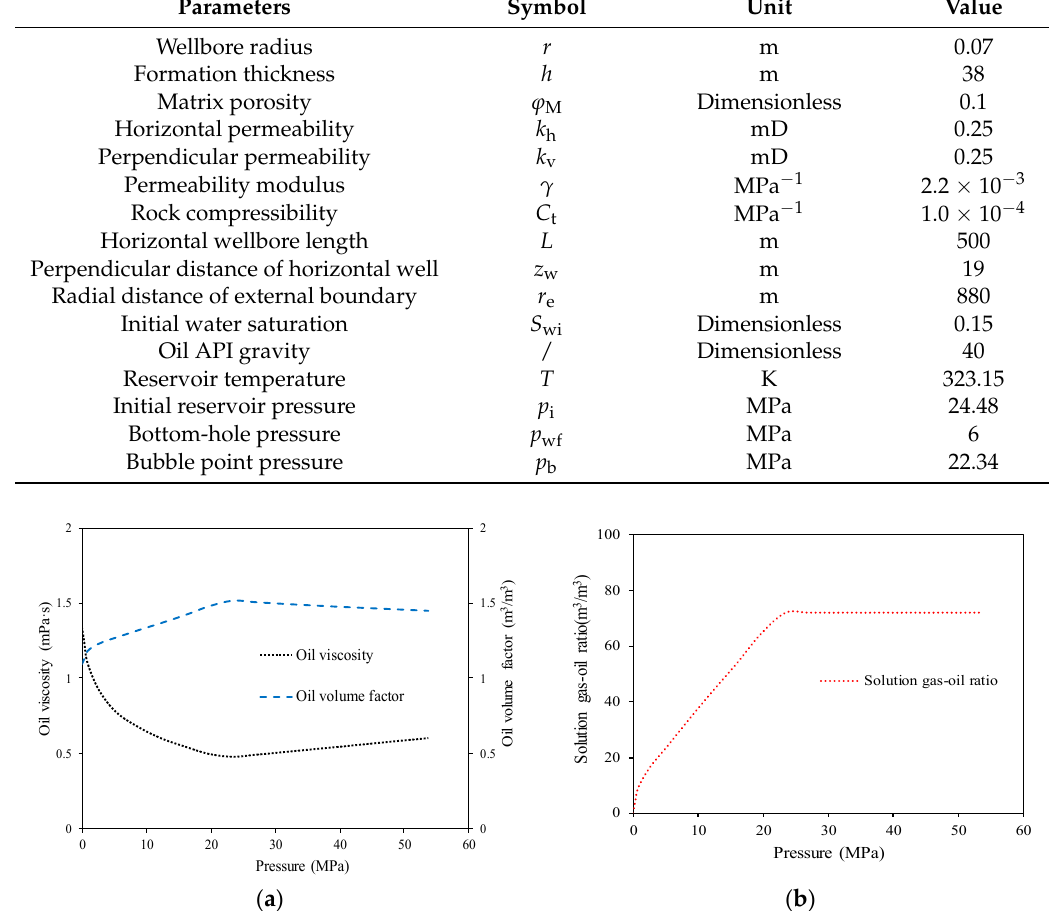
Figure 3. PVT properties used as input for the semi-analytical and numerical model: ( a ) oil volume factor and viscosity curves; ( b ) solution gas-oil ratio curve.